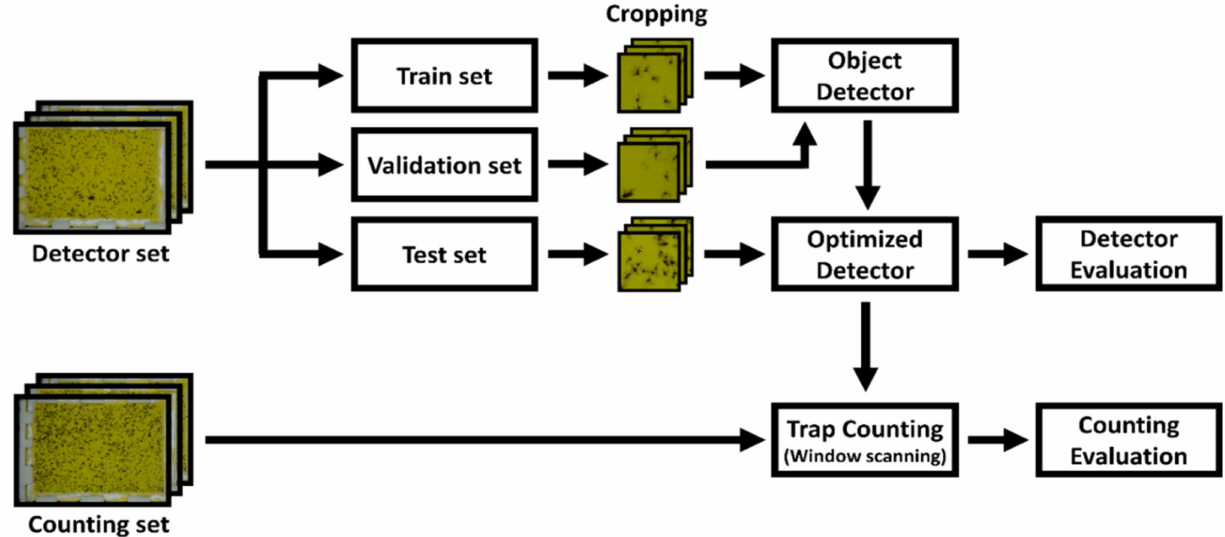
Figure 6. Schematic of the training and evaluation